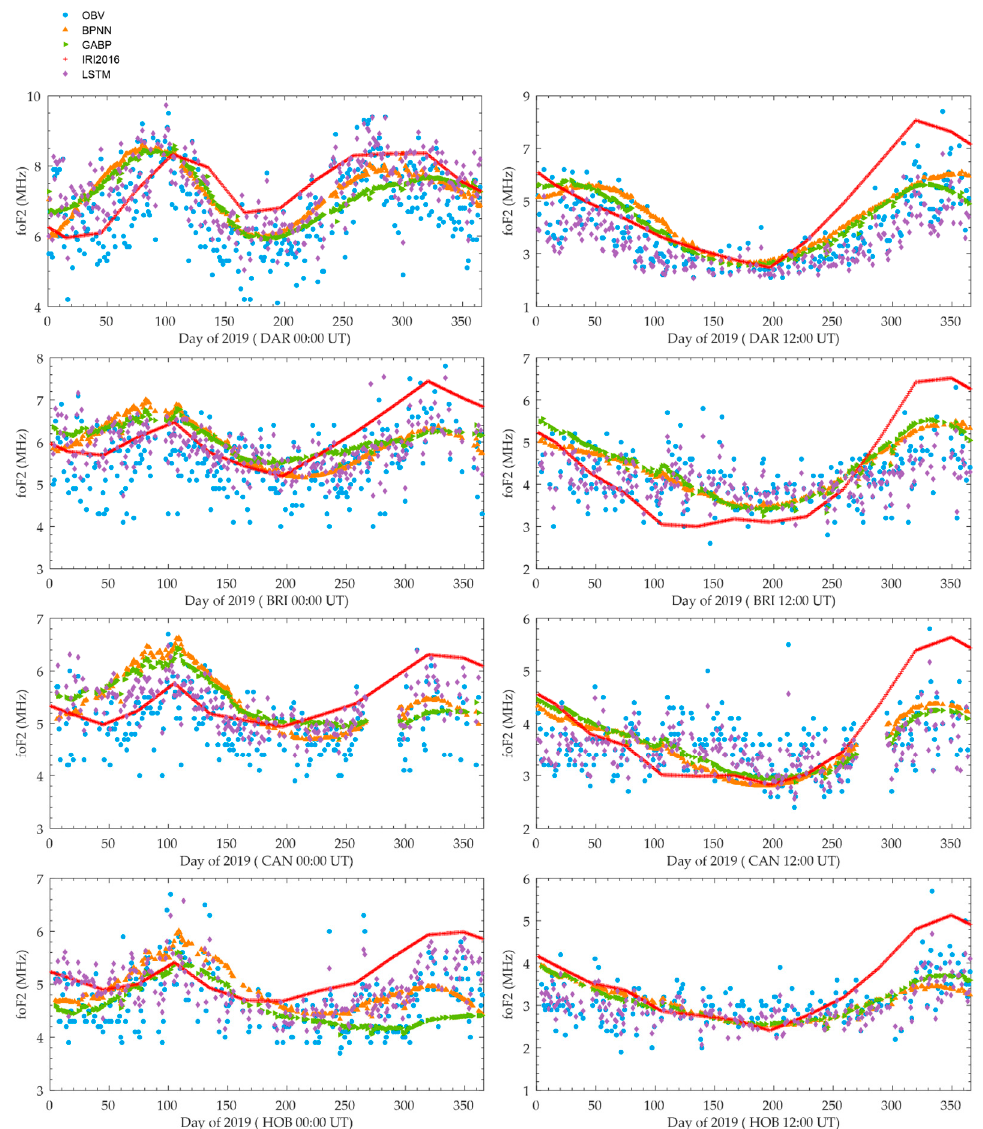
Figure 10. Samples of comparisons of the seasonal variation between observed and 4 models forecasting foF2 values at 00:00 UT ( right panel ) and 12:00 UT ( left panel ) for selected verification stations in 2019.